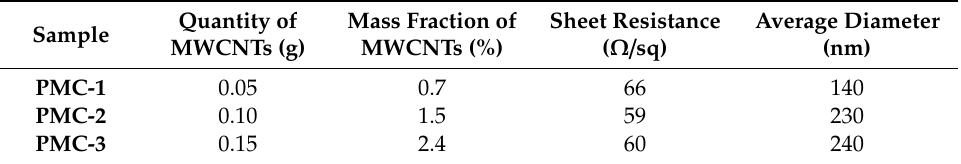
Table 2. Sheet resistance and average diameter of the carbon nanofiber mats fabricated with 12 wt% PAN with the addition of various amounts of mult-walled cabon nanotubes (MWCNTs).